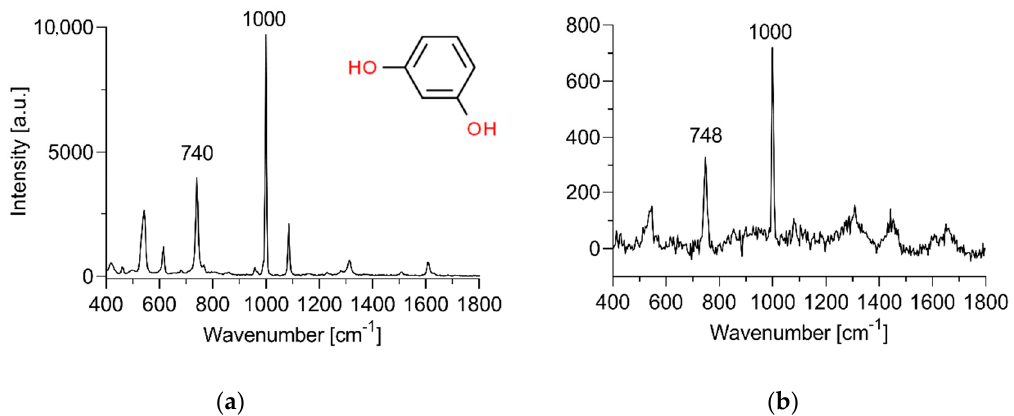
Figure 5. Representative spectra of ( a ) resorcinol in PBS solution (5% w / w ) and ( b ) the stratum corneum of EpiSkin™ RHE following a 12-h topical application of resorcinol in PBS solution (5% w / w